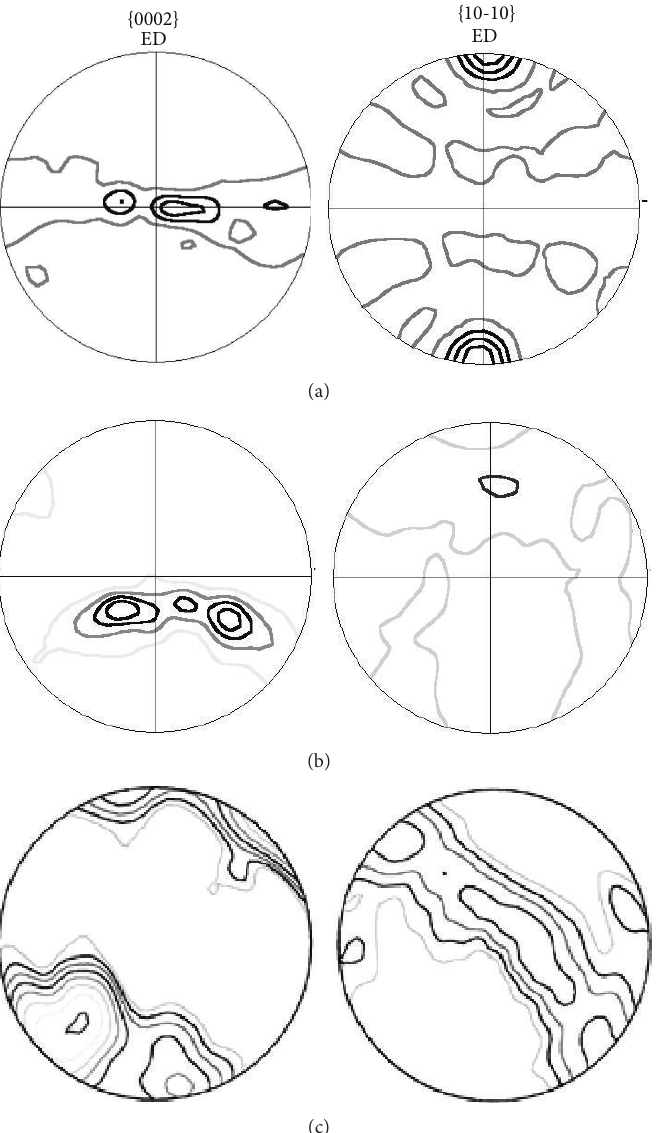
Figure 4: Typical {0002} and {10 - 10} pole figures of Mg alloys processed by (a) conventional extrusion [9], (b) CEC [9], and (c) ECAP (route B c )